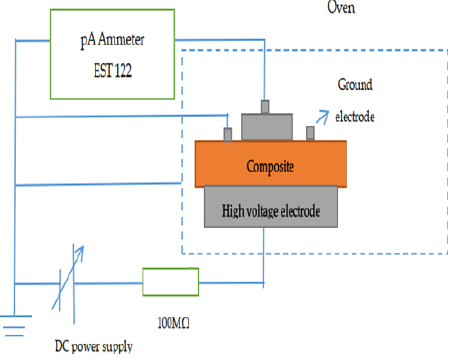
Figure 1. Three-electrode test system schematic.